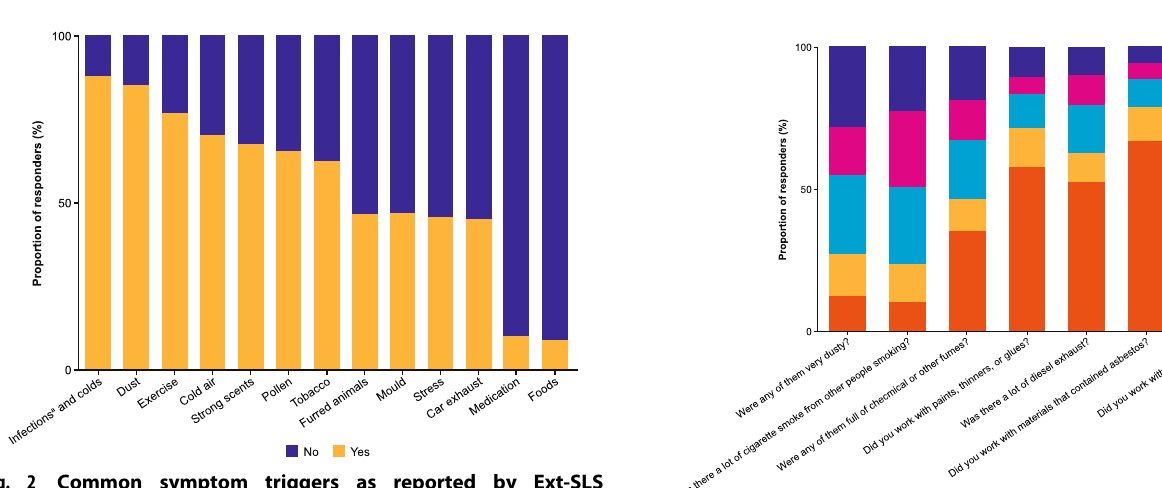
Fig. 1 Disease impact on sleep among participants with asthma and COPD as reported at the time of Ext-SLS consent. CASIS COPD and Asthma Sleep Impact Scale, COPD chronic obstructive pulmonary disease, Ext-SLS extended Salford Lung Study. Note: a One week look-back period for all seven questions. Asthma responders n = 783 – 792, COPD responders n = 335 – 343, variable per question.